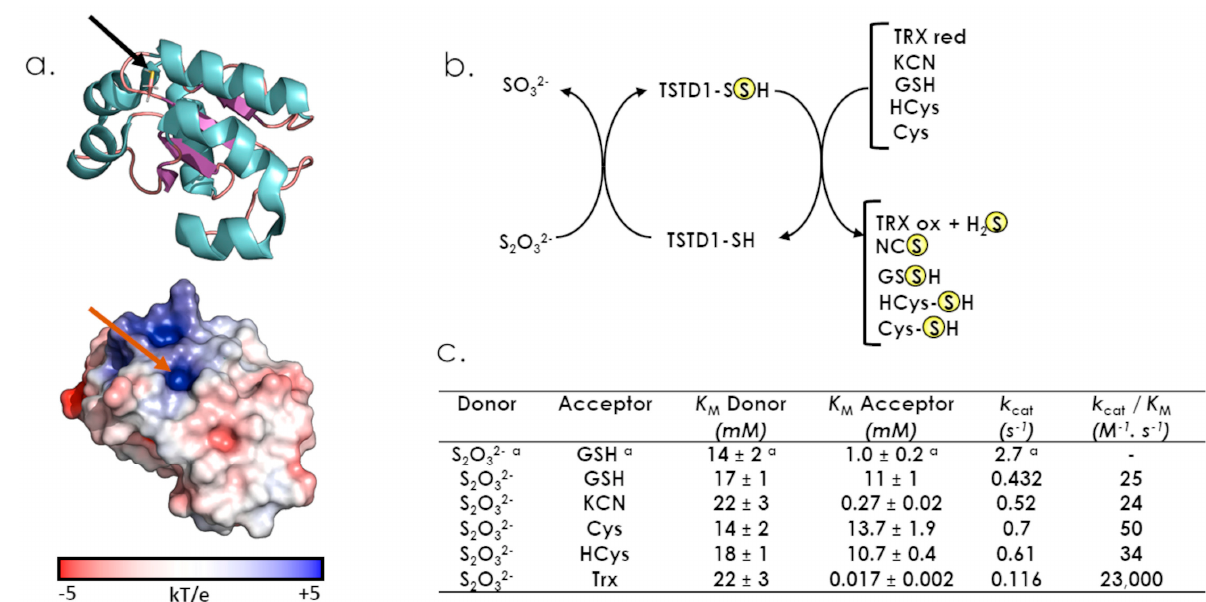
Figure 5. Structural and catalytic properties of TSTD1. ( a ) Cartoon and surface representations of the TSTD1 structure (PDB 6BEV). The active site cysteine is represented in stick and indicated by a black (cartoon) or a red (surface) arrow. ( b ) describes sulfur donors and acceptors for TSTD1. ( c ) Steady-state kinetic parameters for the thiosulfate sulfurtransferase activity of TSTD1 ([36], except for a [35]).